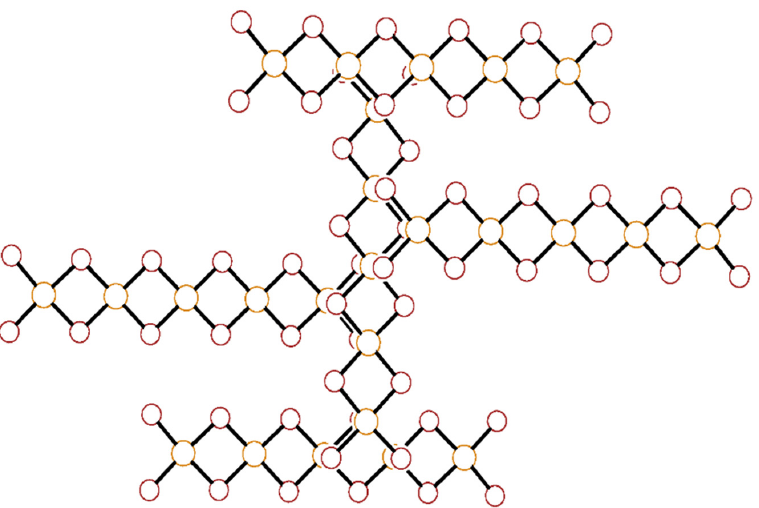
Figure 2. Ball-and-stick diagram of a pentacopper complex aggregated through semicoordinate bond formation to four neighboring oligomers stacked above or below and rotated by 90°. All atoms are drawn as circles of arbitrary radii.